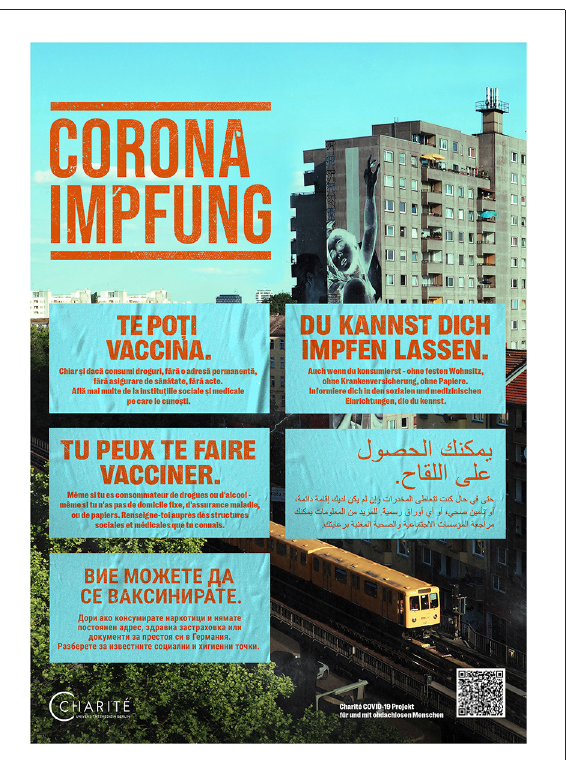
FIGURE3 Multilingual poster disseminated digitally and in print to support the public COVID-19 vaccination campaign for people experiencing homelessness, which also addresses drug use (one out of seven different